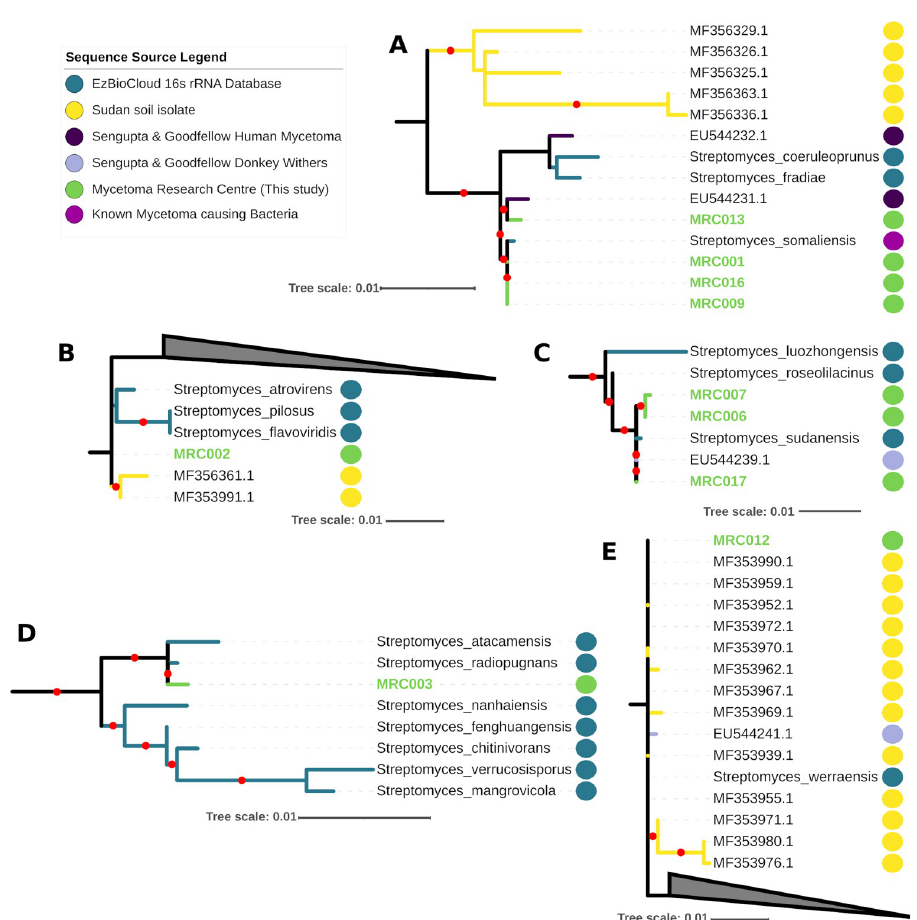
Fig 1. Extracts from the 16S rRNA phylogenies of Streptomyces (full figure in S1 Fig and https://itol.embl.de/ shared/1MX60mtB0Ohk3) inferred using iqtree2 and the GTR+F+R5 model showing the placement of isolates (green dots) with related rRNA sequences from the ezBioCloud 16S rRNA database (blue), soil isolates from Sudan (yellow dots [48]) and isolates collected by Sengupta, Goodfellow and Hamid (NCBI accessions EU544231.1 to EU544241.1 from human actinomycetoma (purple) and from donkey withers (lilac). A red dot on branches indicates ultrafast bootstrap support > 95. Triangles are used to represent collapsed clades.